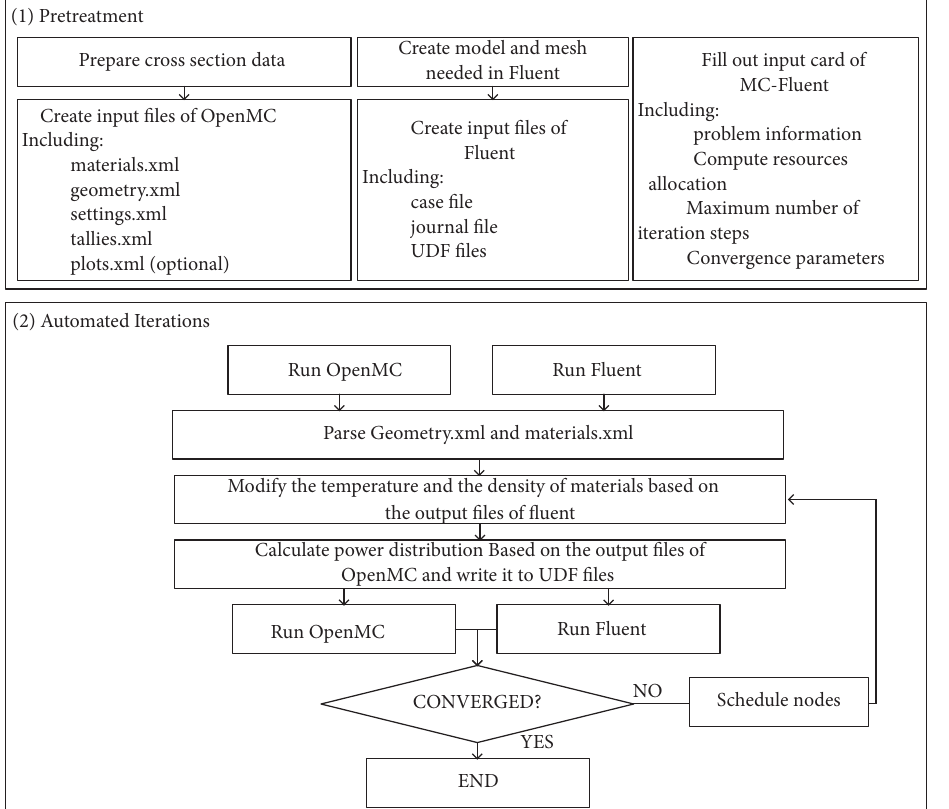
Figure 2: The procedure of MC-FLUENT with block Jacobi-type Picard algorithm.